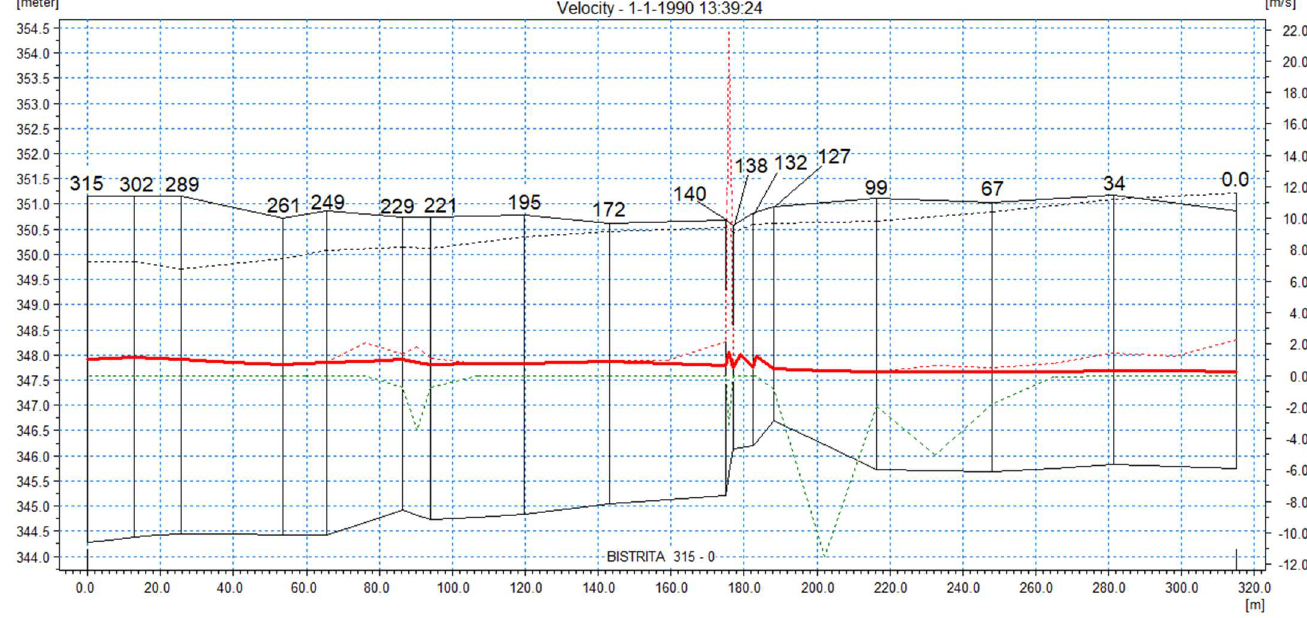
Figure 7. Water speed for flow Q = 3.56 m 3 /s, summer flow recorded in June 2022. For the case where there is only one weir, the existing one.